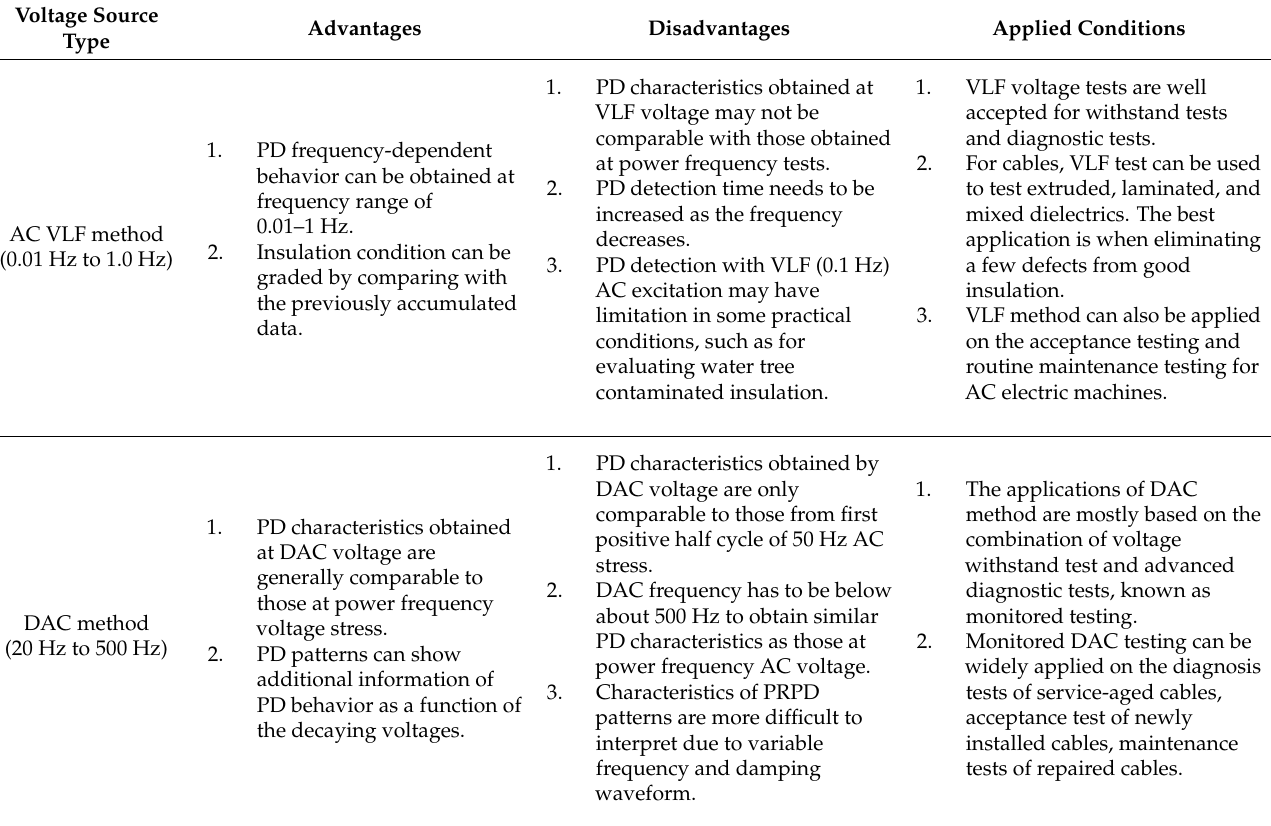
Table 2. Main advantages and disadvantages of VLF and DAC methods for PD